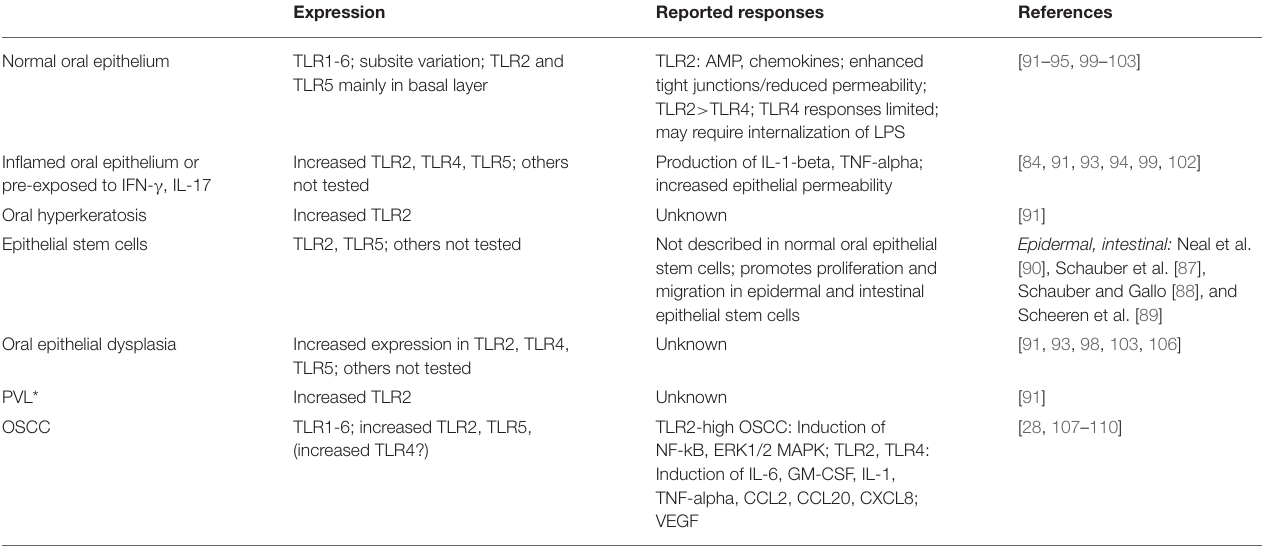
TABLE 1 | Expression and functions of cell-surface TLR in normal and abnormal oral